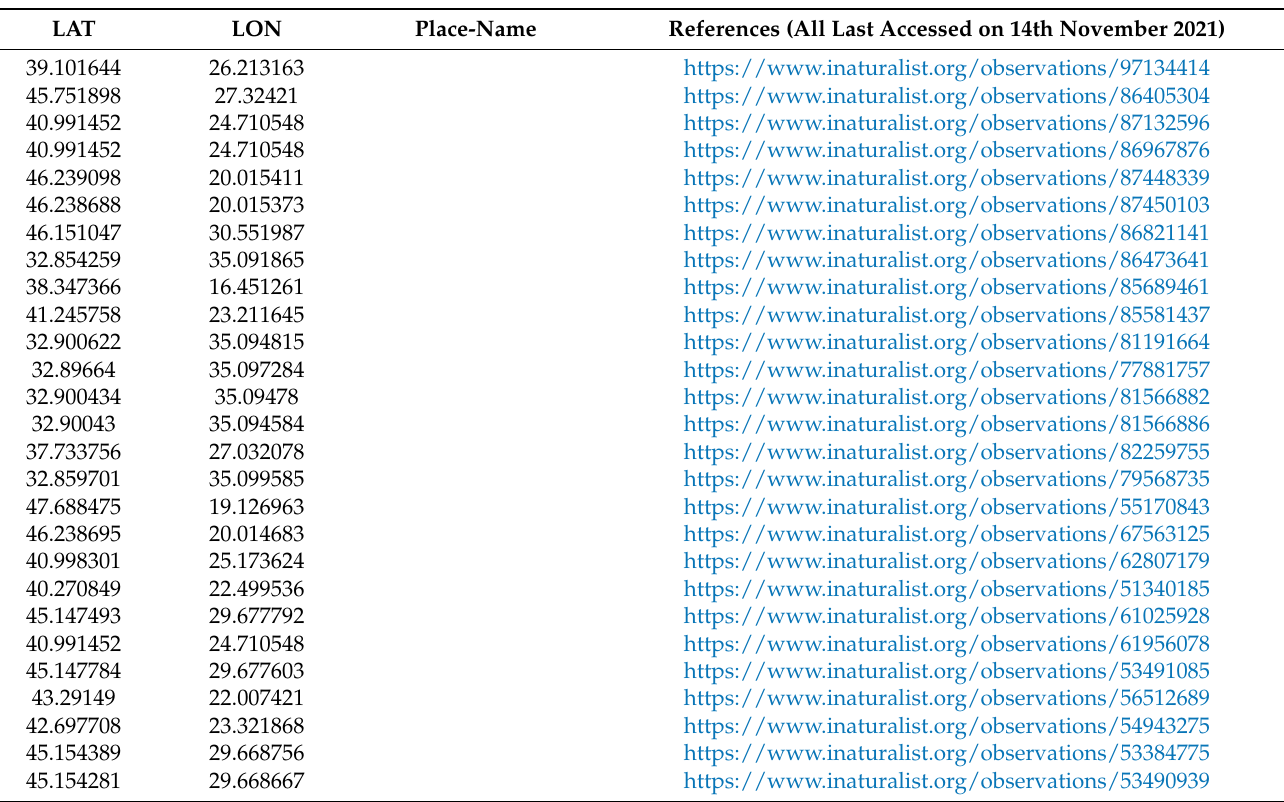
Table A1. Summary of the Presence Records for Anoxia Orientalis on the Basis of Our Original Field Surveys and Literature Data. LAT = latitude; LON =